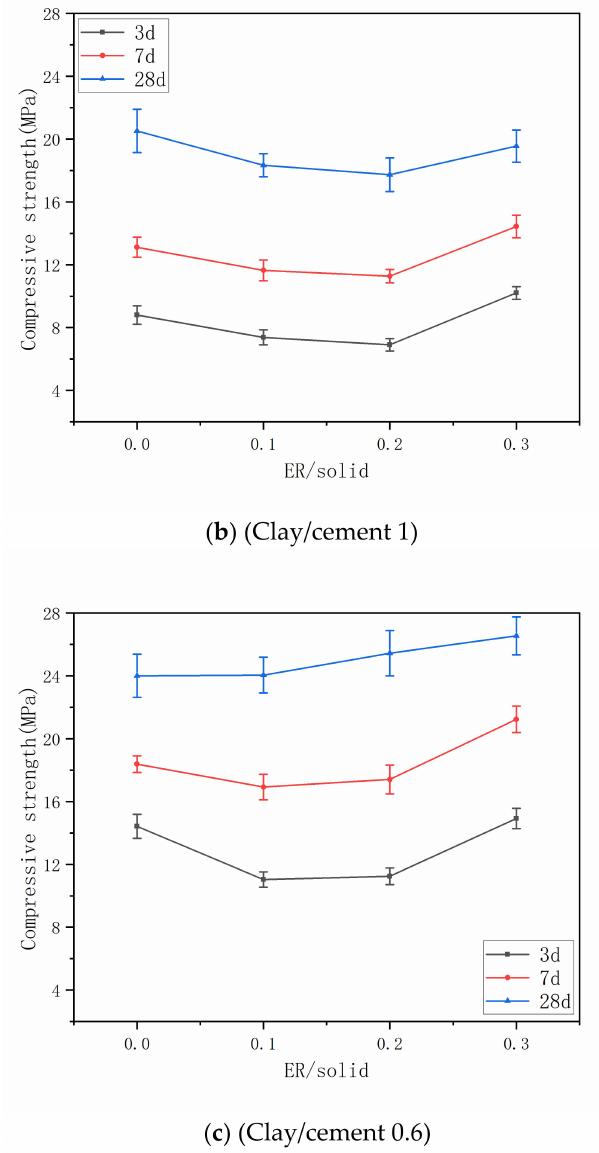
Figure 6. Compressive strength of the grouts with different ER/solid and clay/cement. ( a ) Clay/ cement 1.4; ( b ) Clay/cement 1; ( c ) Clay/cement